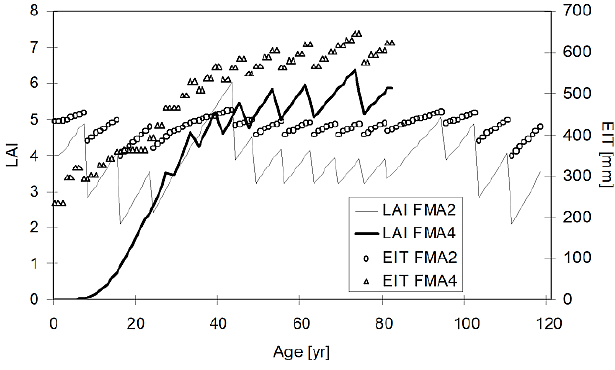
Fig. 2 . Relationships between stand age, leaf area index (LAI) development, and evapotranspiration (EIT = sum of soil and intercepted rain evaporation and transpiration) for single stands of spruce (FMA 4) and beech (FMA